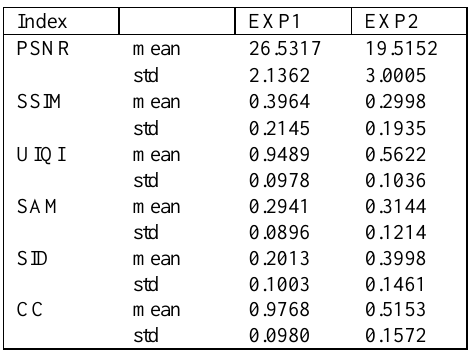
Table 4. Quality matrix results of EXP1 and EXP2 at test